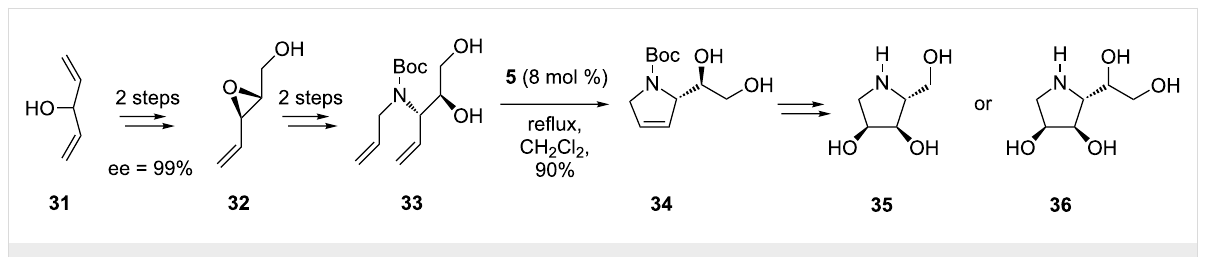
Scheme 6: Synthesis of iminocyclitols 35 and 36